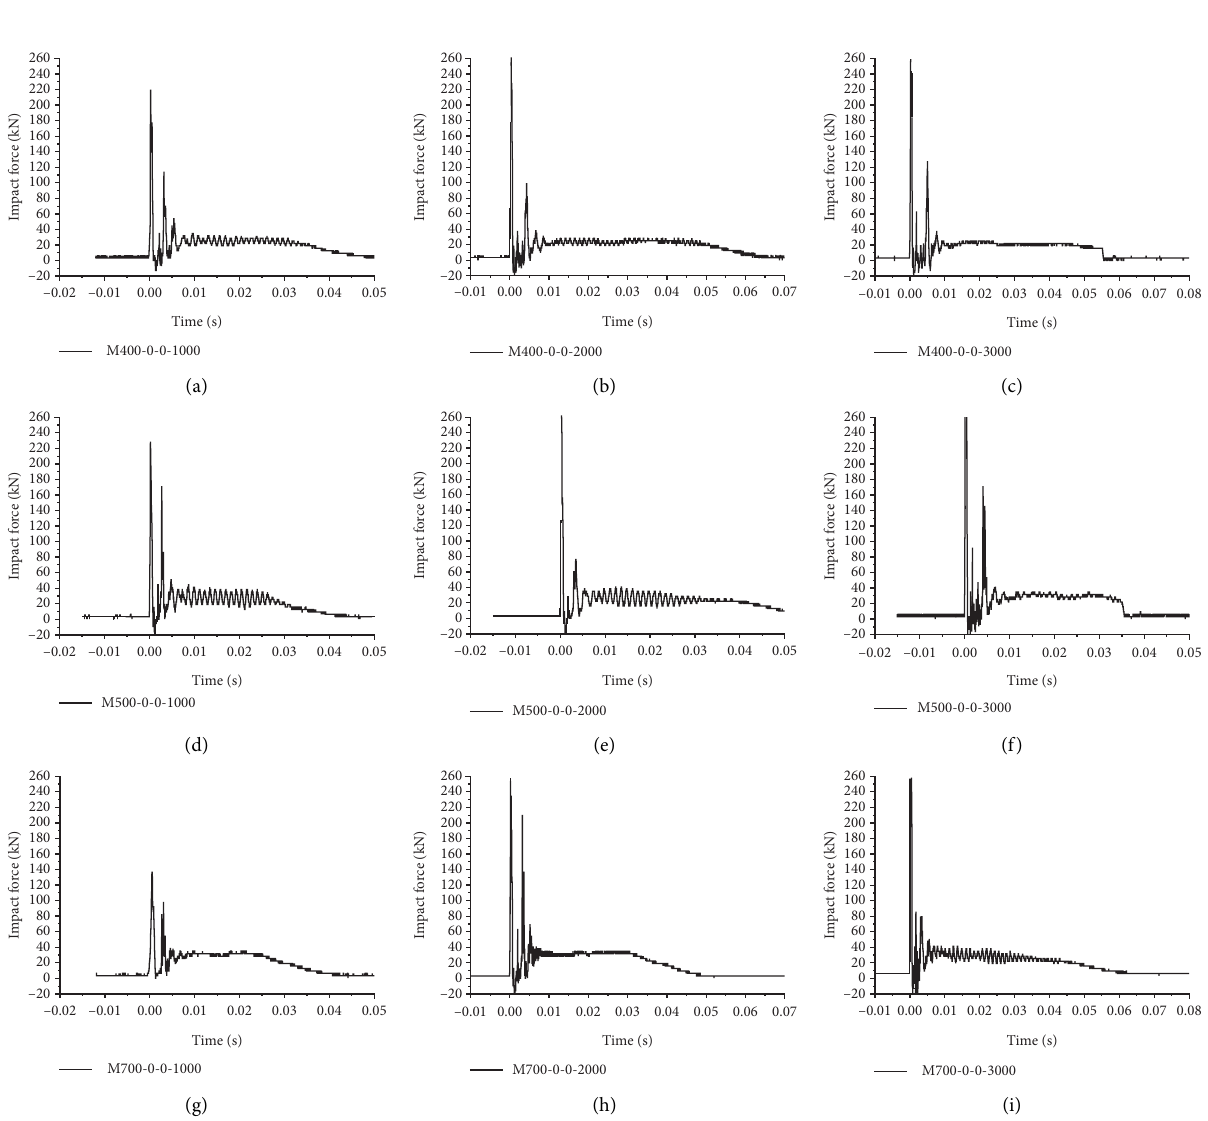
Figure 5: The time-history curves of bolted rock impact force with different strength bolts. (a) M400-0-0-1000. (b) M400-0-0-2000. (c) M400-0-0-3000. (e) M500-0-0-1000. (f) M500-0-0-2000. (g) M500-0-0-3000. (h) M700-0-0-1000. (i) M700-0-0-2000. (j)